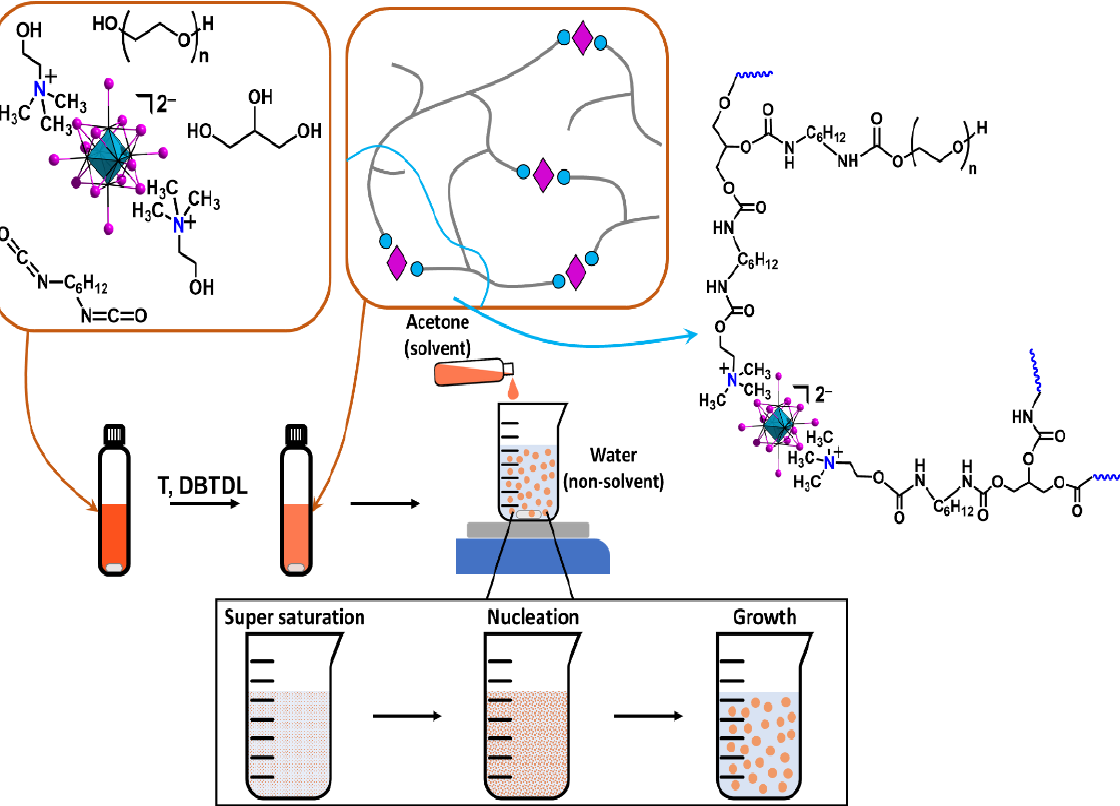
Figure 1. Schematic representation of polyurethane polymerization with a cluster and the formation of nanoparticles .